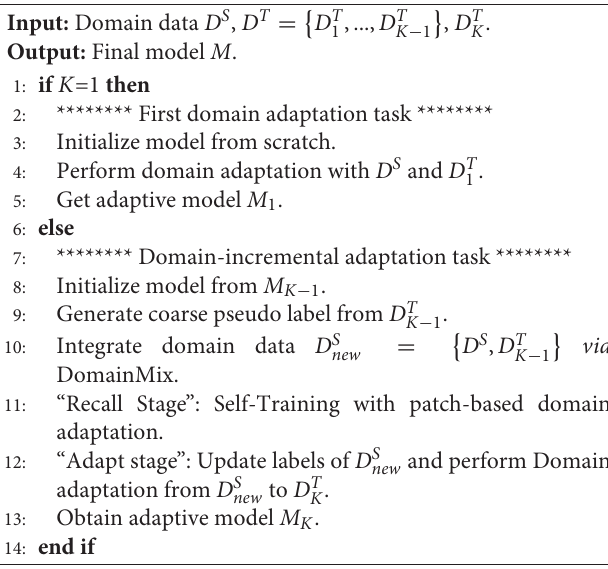
Algorithm 1 | Domain-incremental adaptation